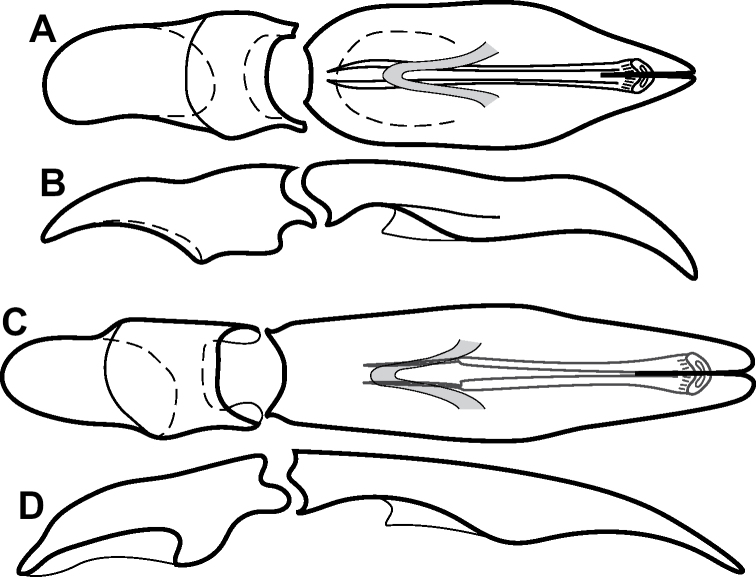
Male genitalia A, BPhelister
microdens: A aedeagus, dorsal B aedeagus, lateral C, DP.
matatlantica: C aedeagus, dorsal D aedeagus, lateral.